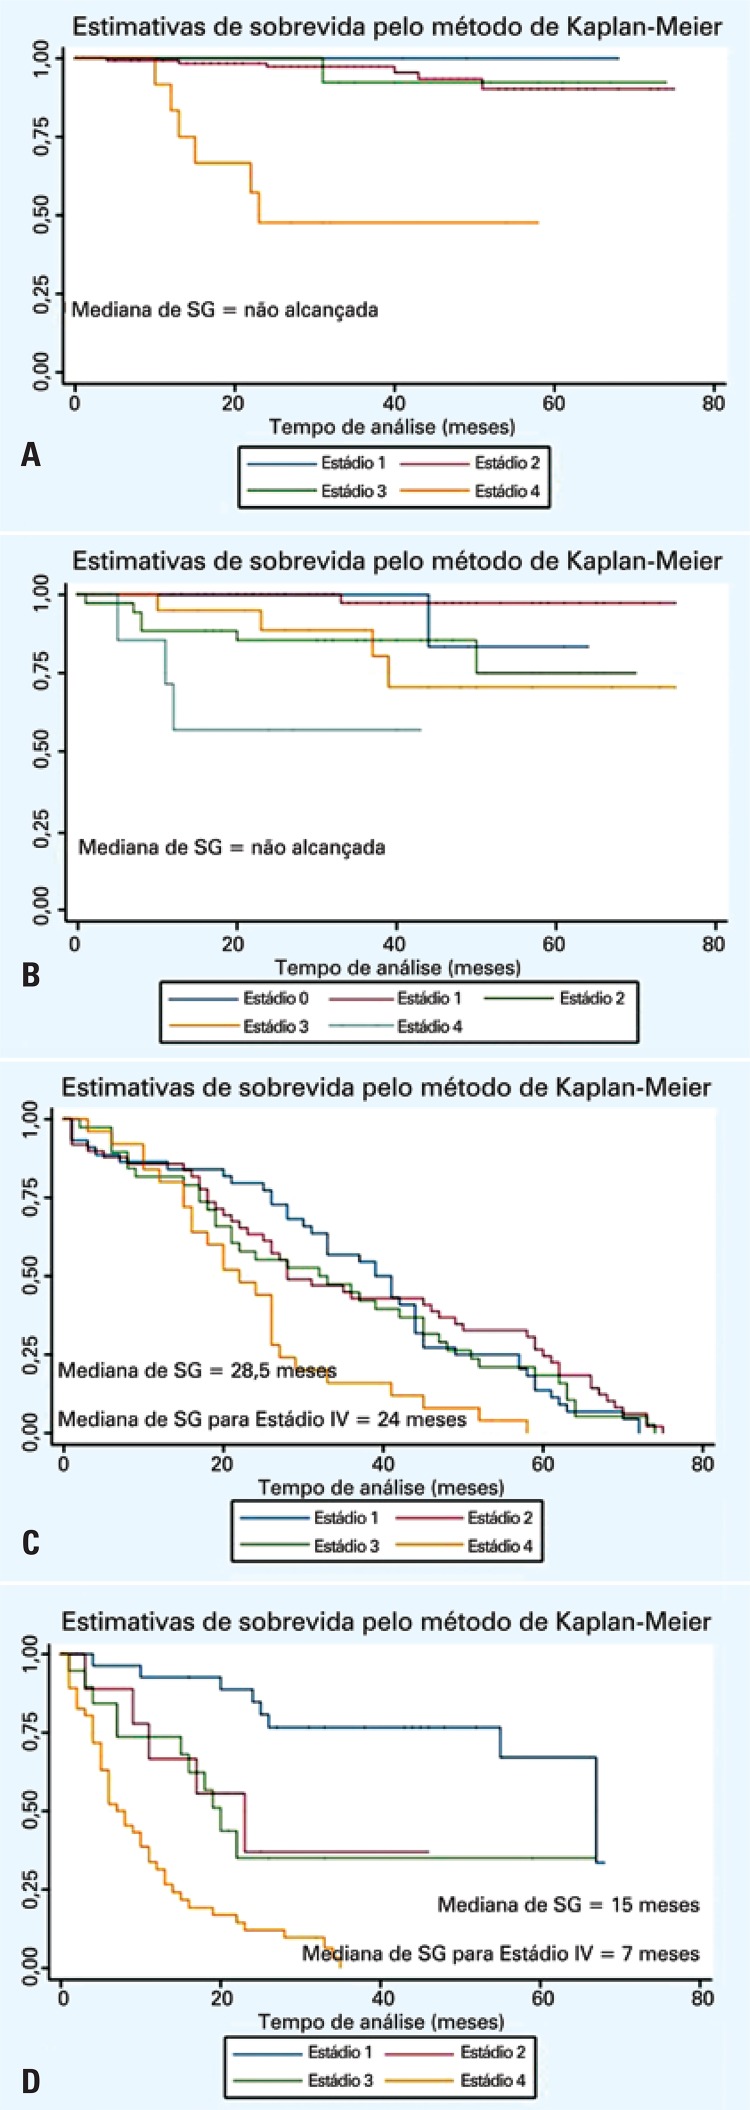
Sobrevida global de pacientes diagnosticados com câncer de próstata (A), mama (B), colorretal (C) e de pulmão (D), conforme estádio, em idosos com tumores sólidos, no Hospital Israelita Albert Einstein, São Paulo, Brasil (2007-2011)